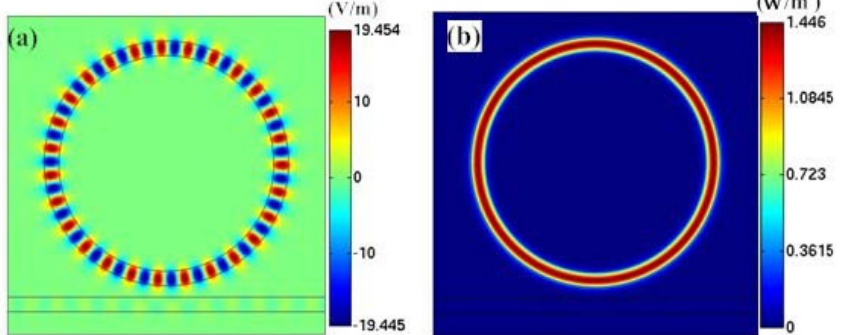
Figure 4. (a) Visualization of the steady-state electric field pattern in the air-core microring resonator at the frequency of f = 198.257 THz ( m = 27). (b) Power flow r distribution. (c) Resonant frequency spectrum of the